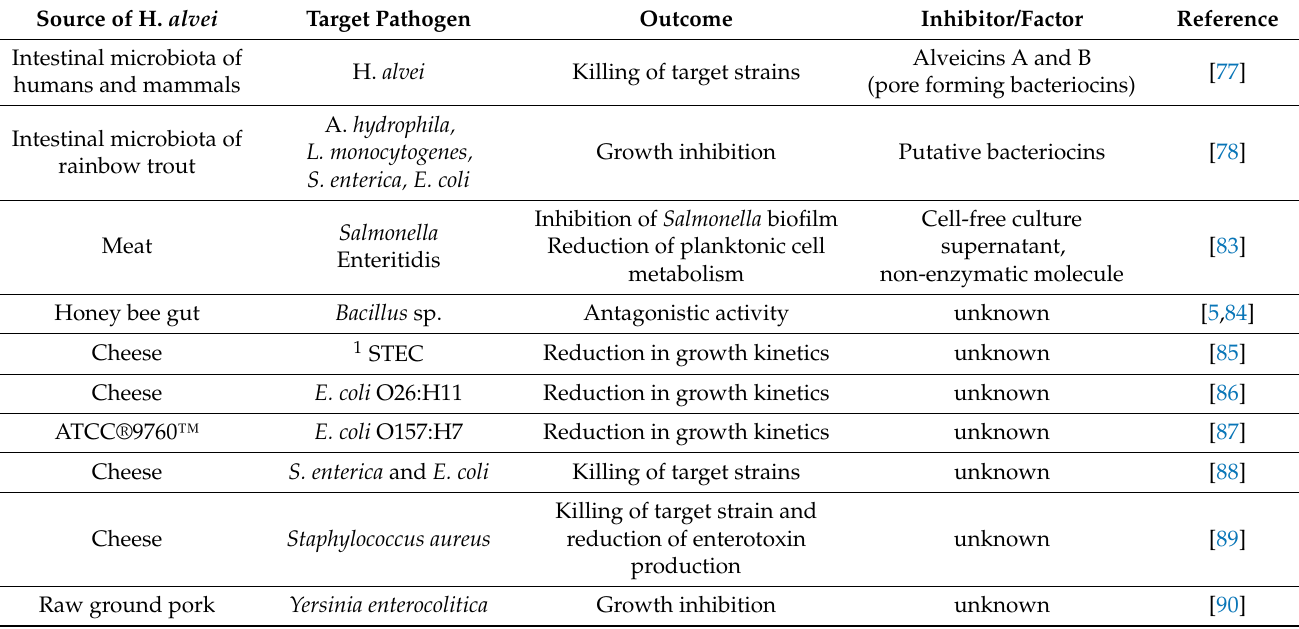
Table 2. Antagonistic activity of H. alvei against